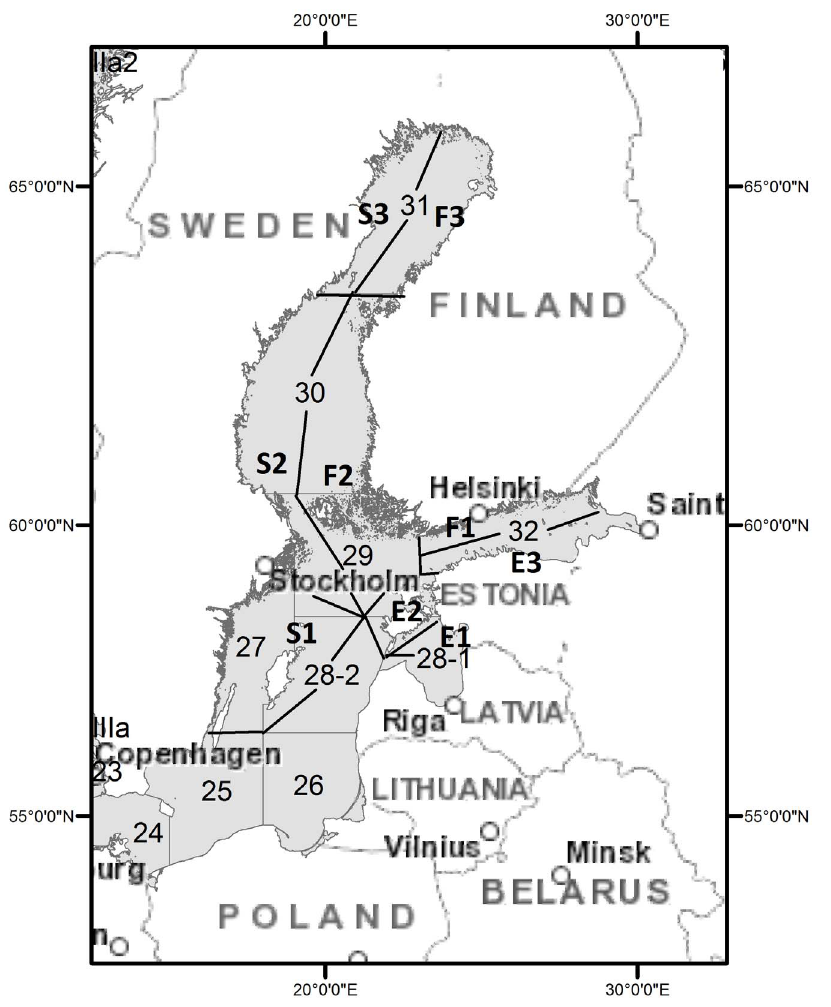
Figure 1. The study area and its division into 9